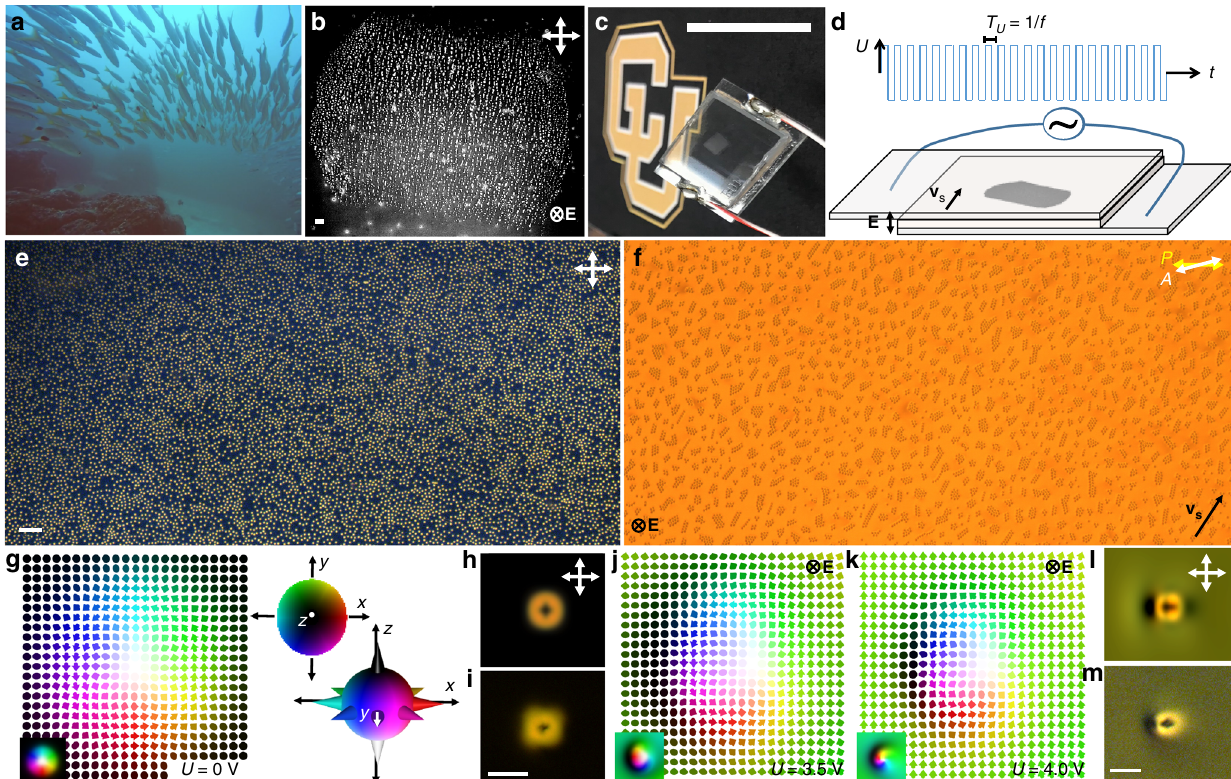
U = 4.0 V U = 3.5 V Fig. 1 Skyrmions and schooling. a Underwater photograph of fi sh schooling. b Zoomed-out grayscale polarizing optical micrograph of a school of skyrmions. The scale bar in the bottom left is 100 µ m. c Photograph of the skyrmion school shown in b , visible with the unaided eye as the cloudy region within the sample. The scale bar is 1 in. d Schematic of a sample with voltage application across the LC by using transparent electrodes on the inner surfaces of the con fi ning substrates. The dark region within the schematic represents the moving skyrmion school shown in b , c . e , f Low-magni fi cation experimental polarizing micrographs of a region within the school at U = 0 V ( e ) and U = 3.5 V ( f ). The scale bar in the bottom left of e is 100 µ m. g Numerically simulated n ( r ) of an individual skyrmion at U = 0 shown by arrows colored according to points on the two-sphere, as shown in the right-side inset. h , i Computer-simulated polarizing micrograph ( h ) closely matches its experimental counterpart ( i ). Numerically simulated n ( r ) of skyrmions at U = 3.5 V ( j ) and U = 4.0 V ( k ), with corresponding computer-simulated ( l ) and experimental ( m ) polarizing micrographs at U = 4.0 V. Bottom-left insets in g , j , k are smoothly colored representations of n ( r ). The scale bars in i and m are 10 µ m. Directions of E , skyrmion motion velocity direction v s , U , T U , double arrows denoting polarizer orientations and time t are marked throughout. Numerical simulations are based on material parameters of LC mixture of nematic MLC-6609 and right-handed chiral additive CB-15 (see Methods) and d ≈ p ≈ 10 µ